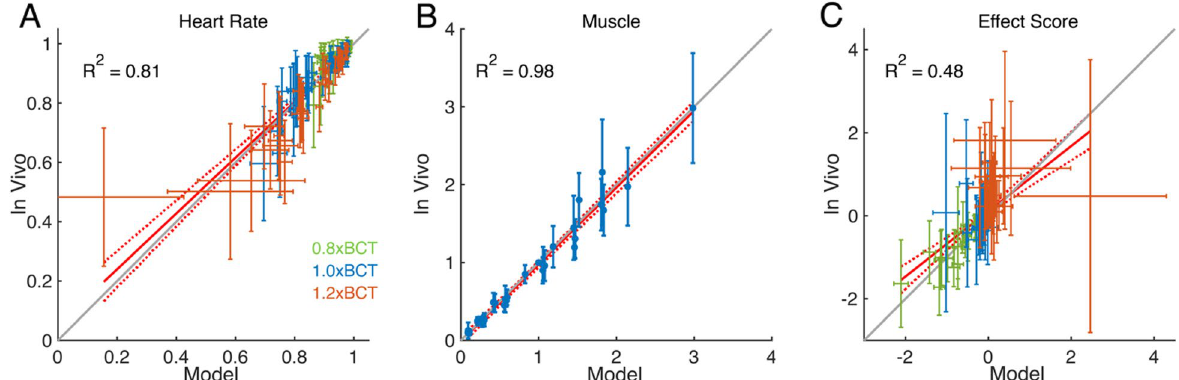
Fig. 9 Comparisons of simulated and in vivo data. A Comparison of modeled and in vivo HR norm at stimulation amplitudes of 0.8xBCT (green), 1.0xBCT (blue), and 1.2xBCT (orange). B Comparison of modeled and in vivo EMG norm and Force norm at only 1.0xBCT. C Model effect score calculations used HR norm at the color-coded stimulation amplitudes, but Force norm at only 1.0xBCT. Data are presented as mean SD (vertical bars ± for in vivo SD and horizontal bars for model SD), n 8-10 per parameter set for in vivo data, n 10 runs per parameter set for HR model and n 1 = = = run per muscle model. Coefficient of determination ( R 2 ) of linear fit (solid red line in each panel; 95% confidence interval in dashed red lines in each panel). Gray 1:1 lines represent perfect agreement (in vivo =